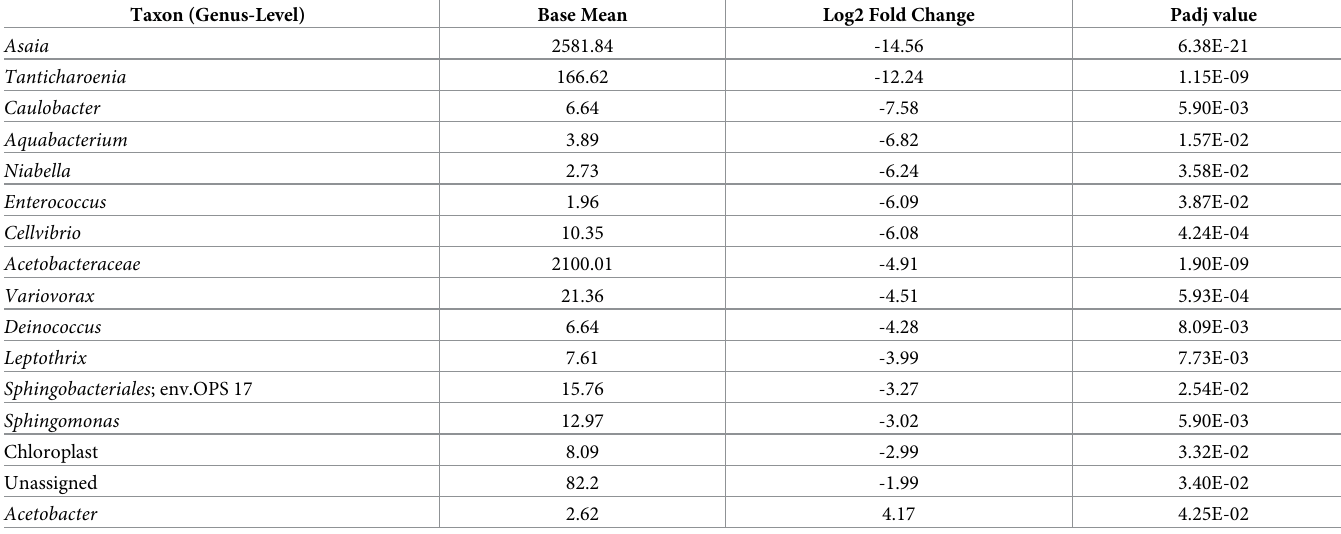
Table 1. Relative abundance of bacterial genera, Δ aslrim1 vs wild-type. Taxon